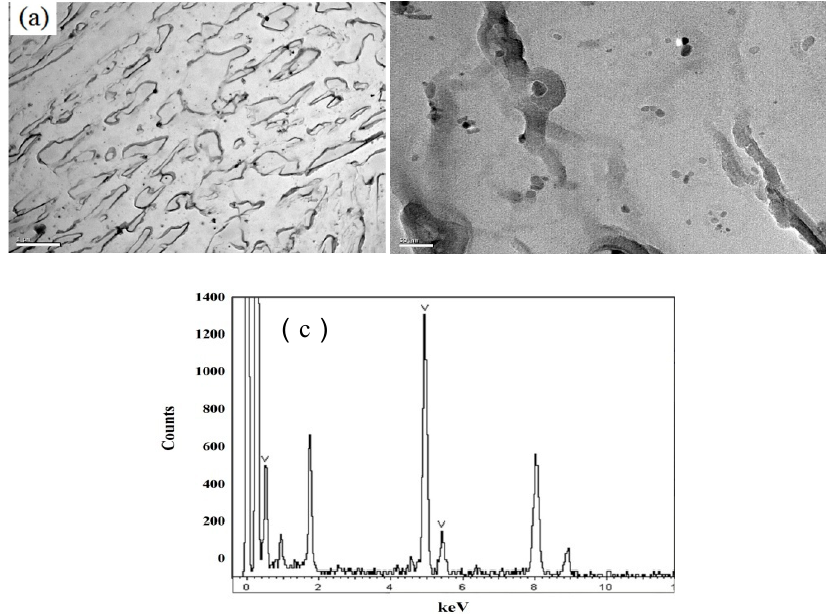
Figure 7. TEM observation of 0.098%V TAM steel: ( a ) Microstructure, ( b ) Precipitate, ( c ) EDS result indicating V precipitates.